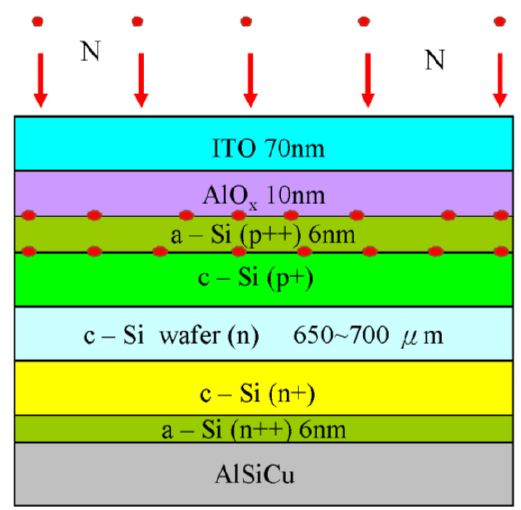
Figure 2. Passivated solar cell by using